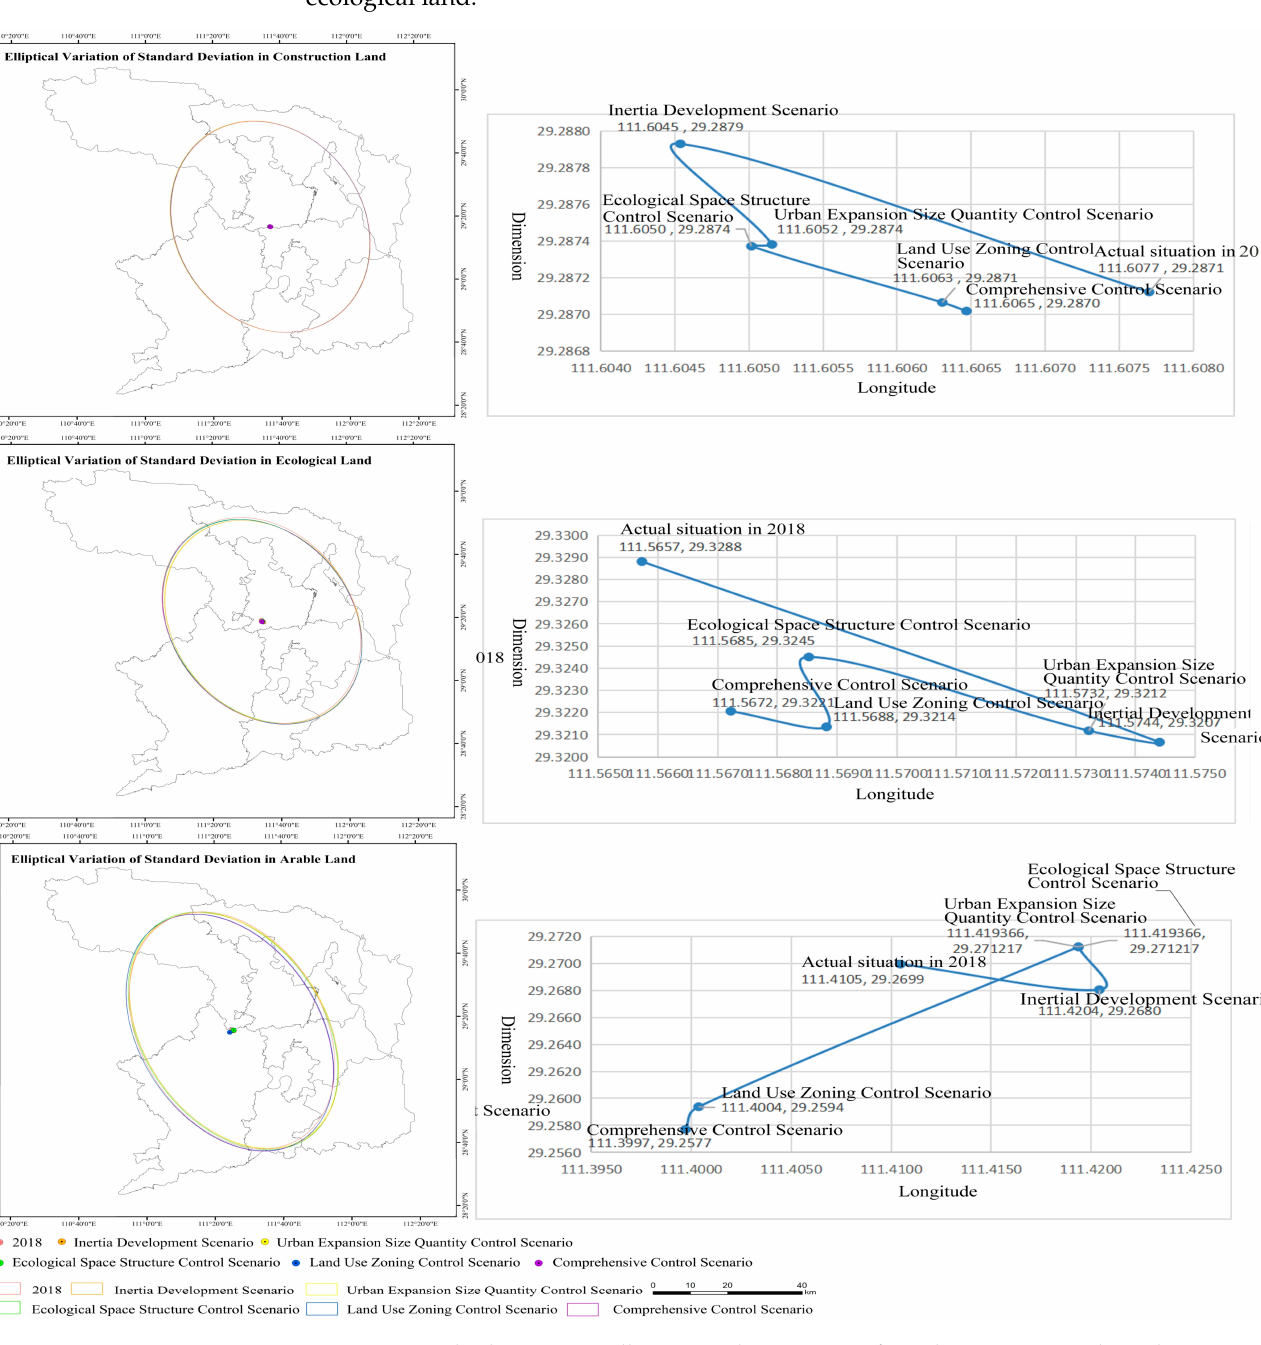
Figure 6. Standard Deviation Ellipse Distribution Map of Land Use Types in Changde City under Different Scenarios.